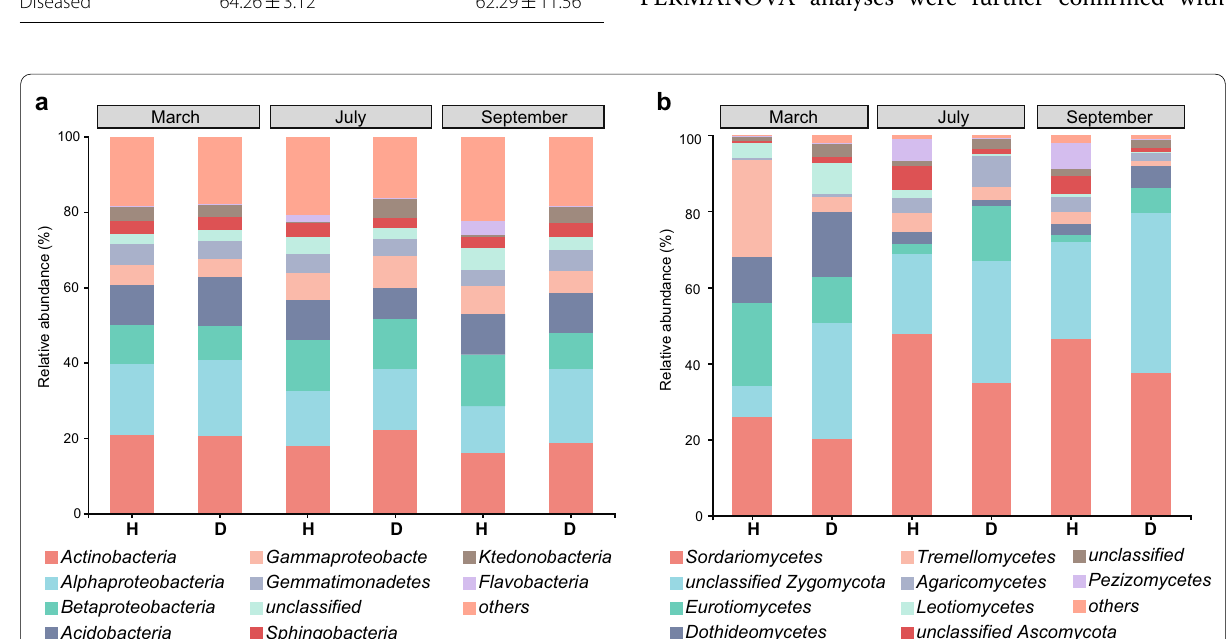
Fig. 1 Relative abundance of the top-10 a) bacterial and b) fungal classes for samples collected form healthy (H) and diseased (D) fields in